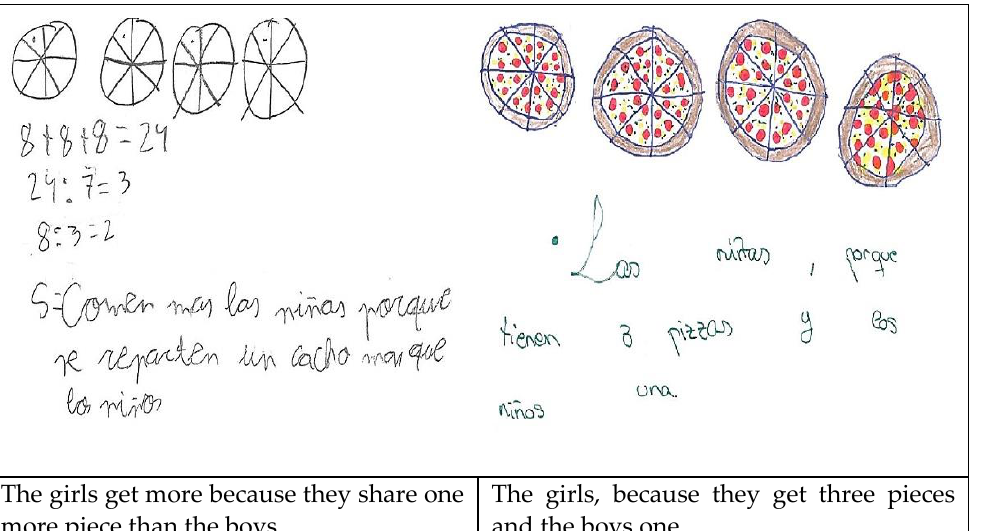
Figure 3. Examples of pieces and incomplete pieces strategies.